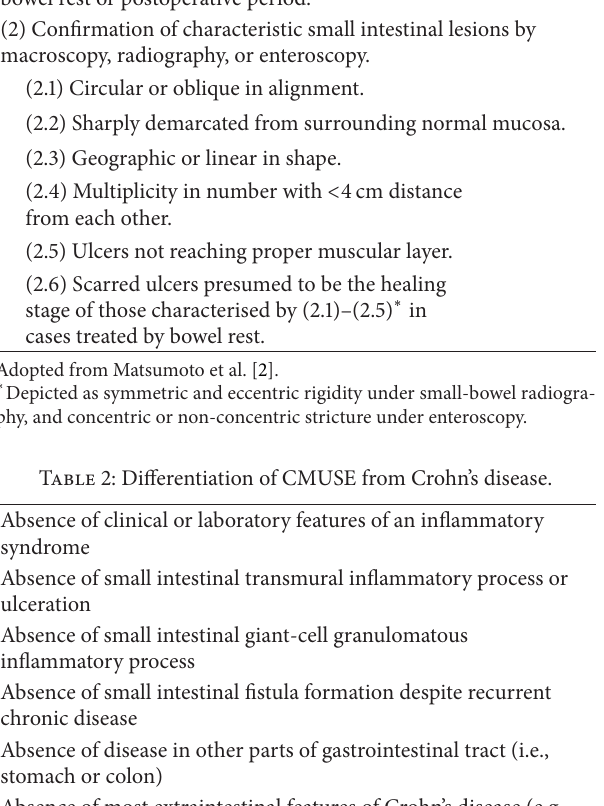
Table 1: Diagnostic criteria of CMUSE/CNSU.